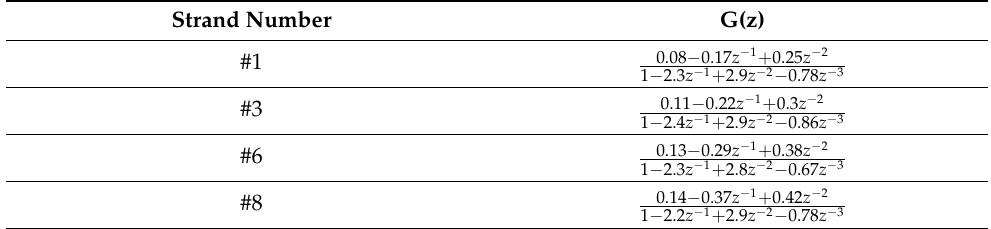
For the #1, #3, #6, and #8 strands, the tension fluctuation and deviation between different strands were more obvious. Therefore, the system model for these strands at 300 r/min can be established as shown in Table 4. Table 4. Models of tension control systems for each